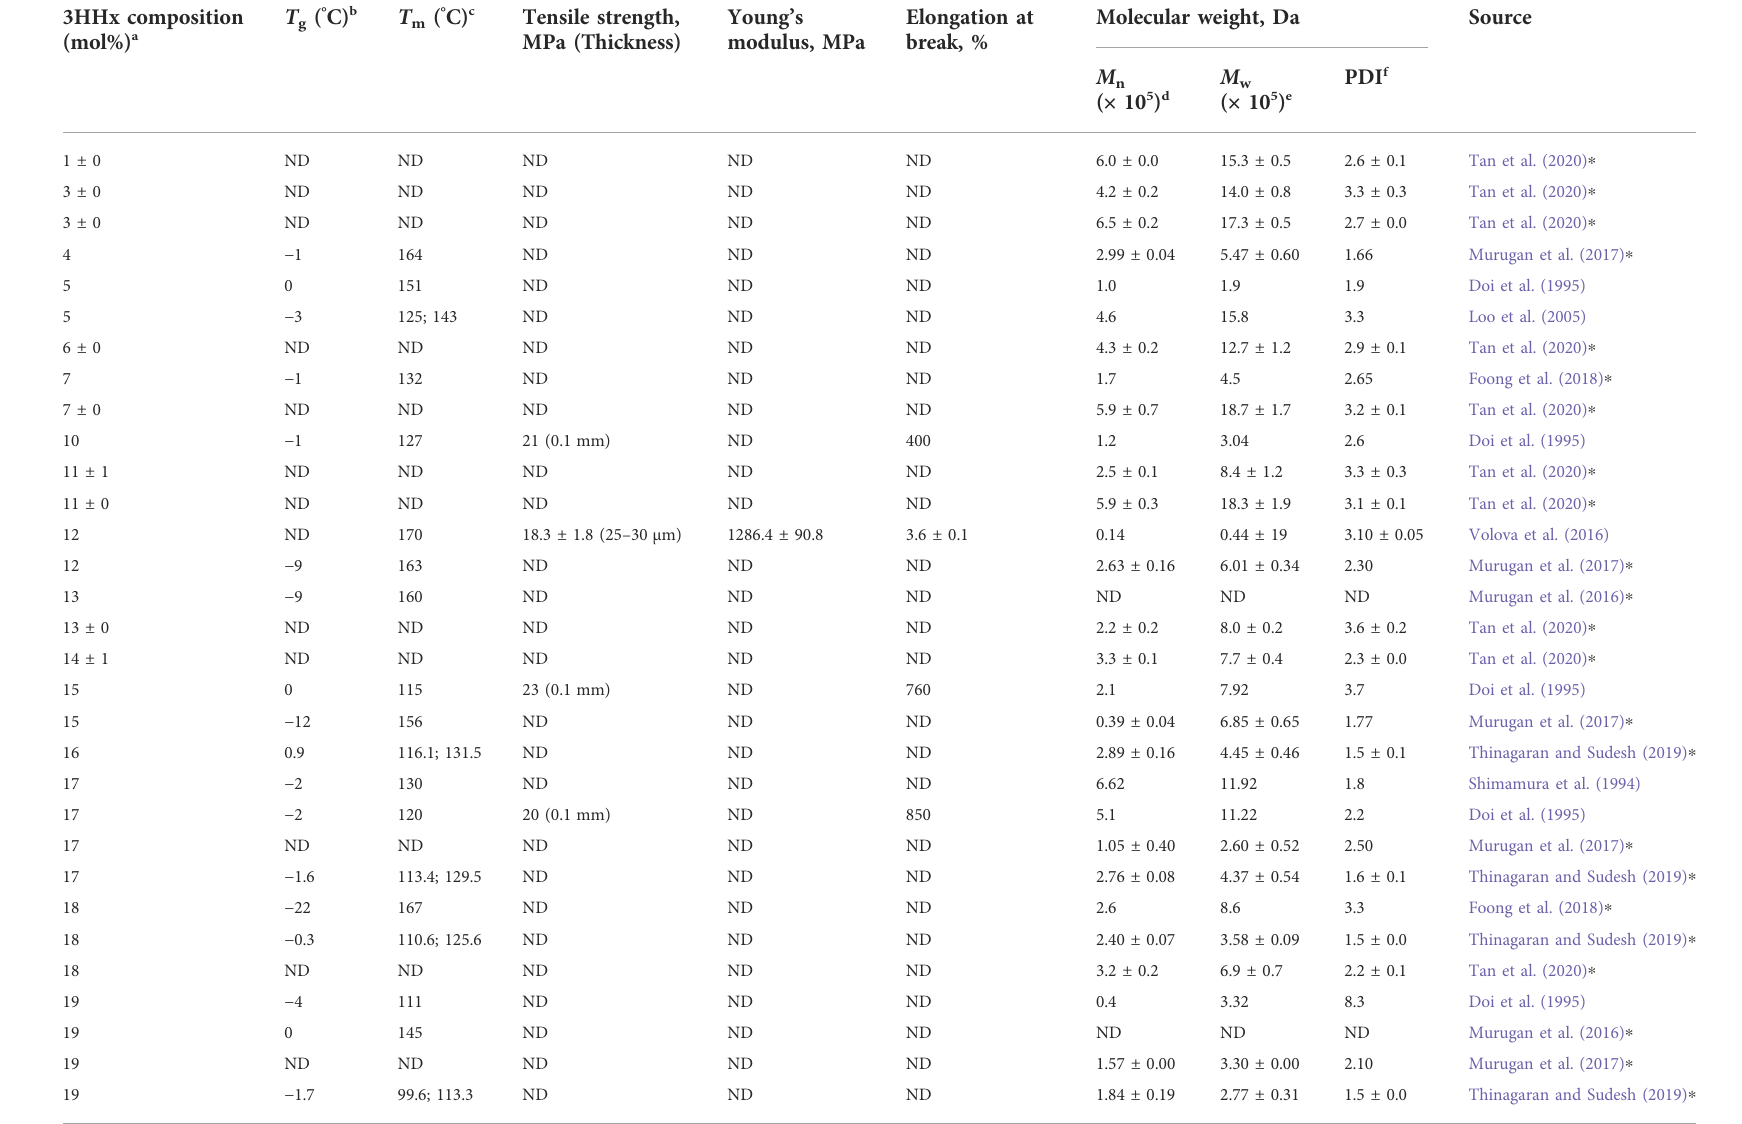
TABLE 1 The physicomechanical properties of P(3HB- co